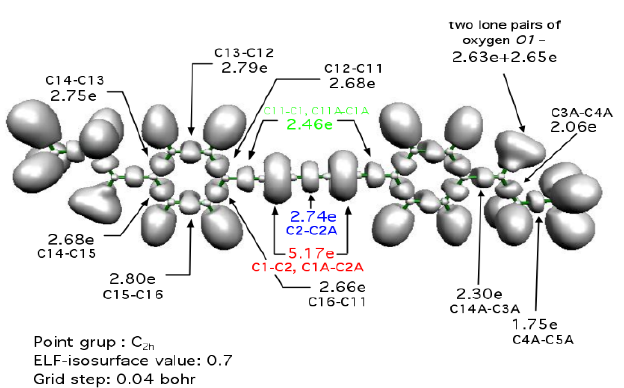
Figure 4. 3D plot of the Electron Localization Function (ELF) for 1 calculated at the B3LYP/6-311++G(d,p) computational level. The bonding localization domains V(C,C), V(C,H), non-bonding domains V 1 (O)∪V 2 (O) of the oxygen atoms, and core domains C(C), C(O) are visible. The basin populations for V(C,C) and V 1 (O)∪V 2 (O) are presented in the picture.